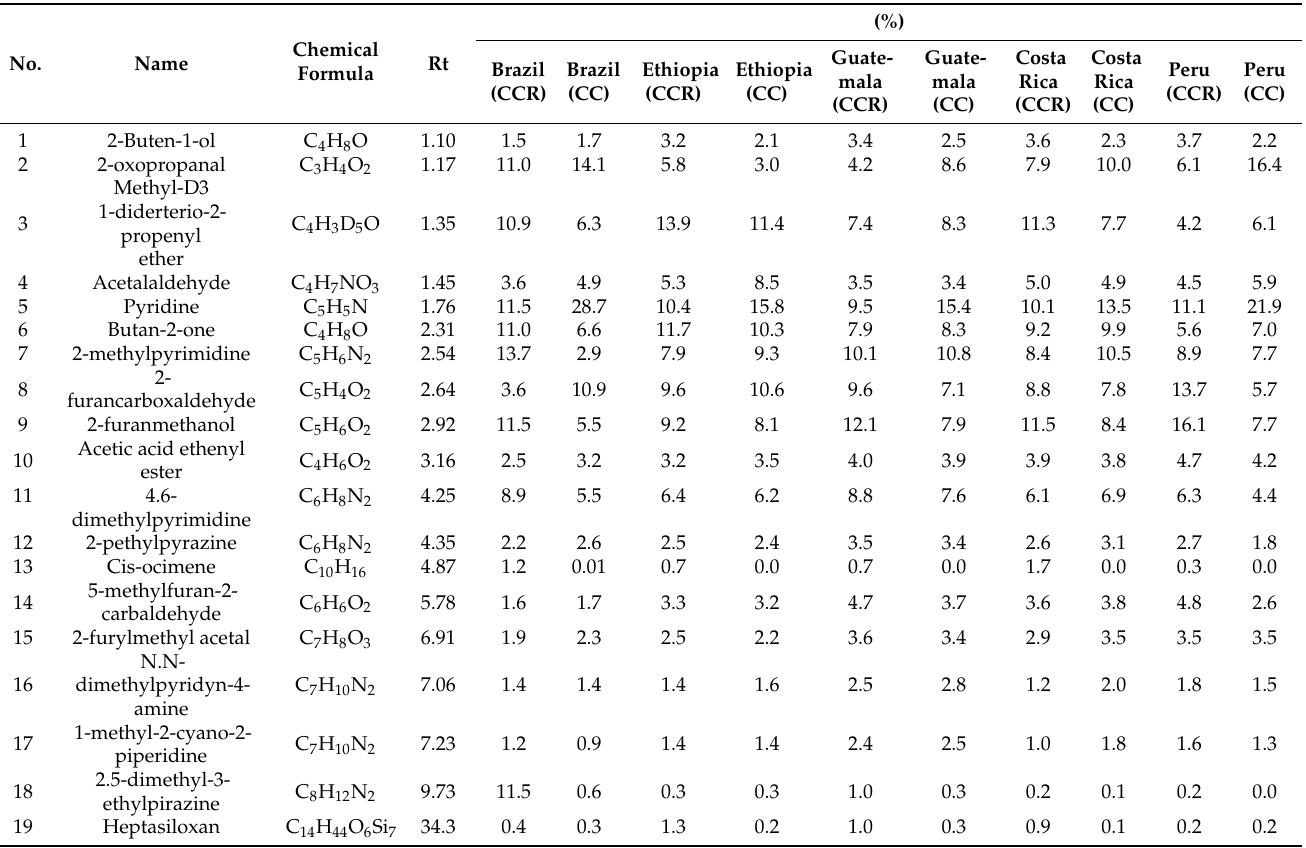
Table 1. Volatile compounds determined in the chromatographic analyses. %—percentage share of the compound in the tested sample immediately after CCR and CC roasting. Rt—retention time for Brazil Santos, Guatemala Comal, Costa Rica La Pastora, Ethiopia Sidamo, and Peru El Palto Organic coffee